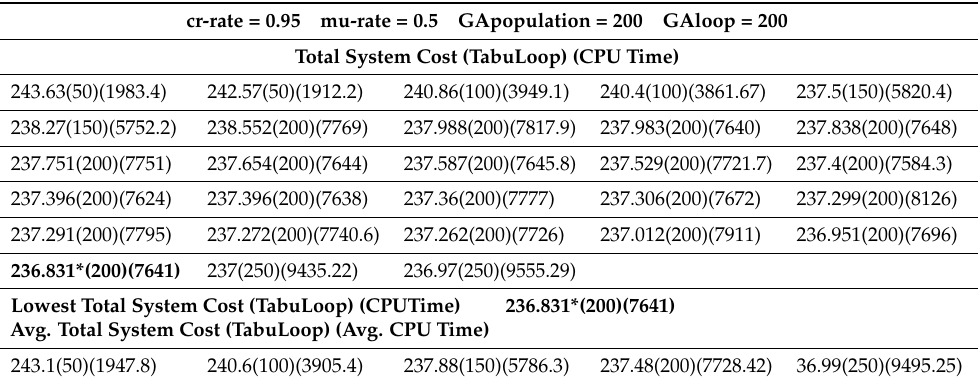
Table 7. The total system costs of 28 simulation runs obtained by TS–MGA for the n -stage standby system. cr-rate = 0.95 mu-rate = 0.5 GApopulation = 200 GAloop = 200 Total System Cost (TabuLoop) (CPU